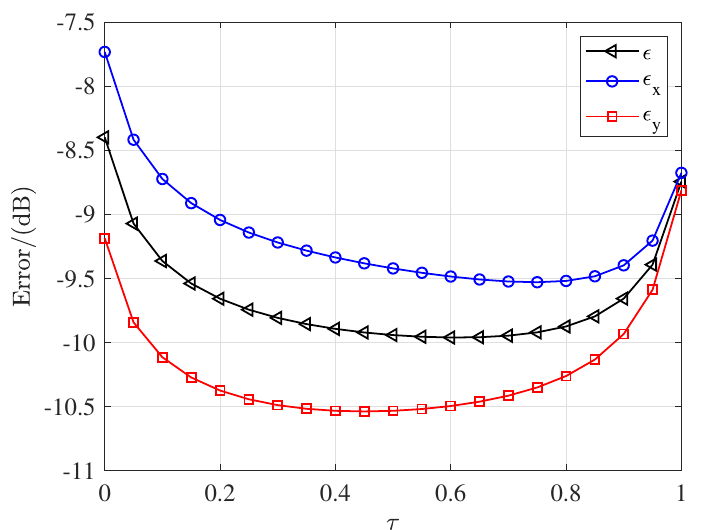
Figure 8. The NMSE of the reproduced intensity at controlled points. The reverberation time RT 60 = 200 ms and the control filter length J = 400.